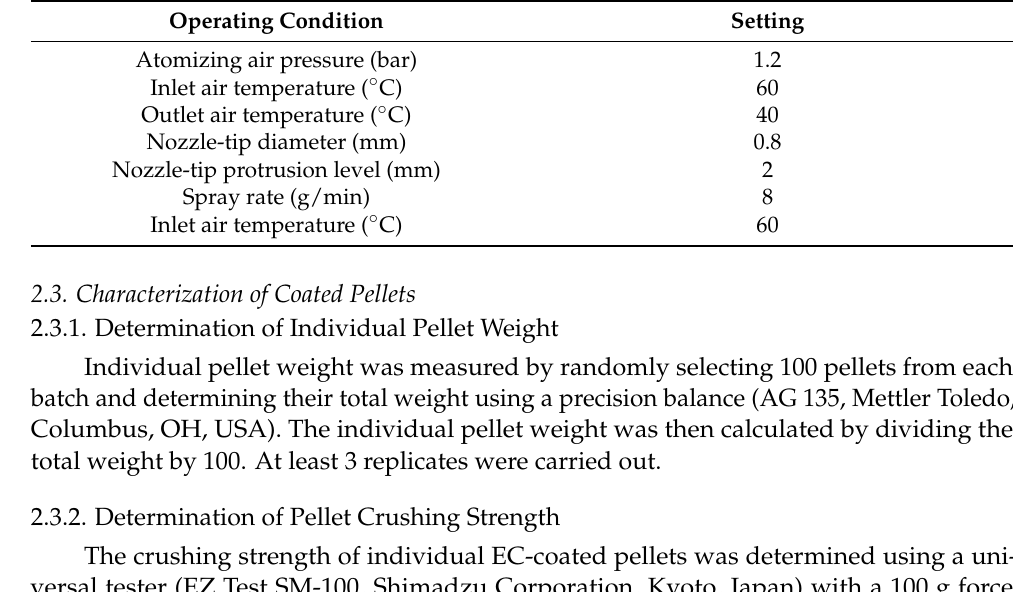
Table 1. EC coating process parameter